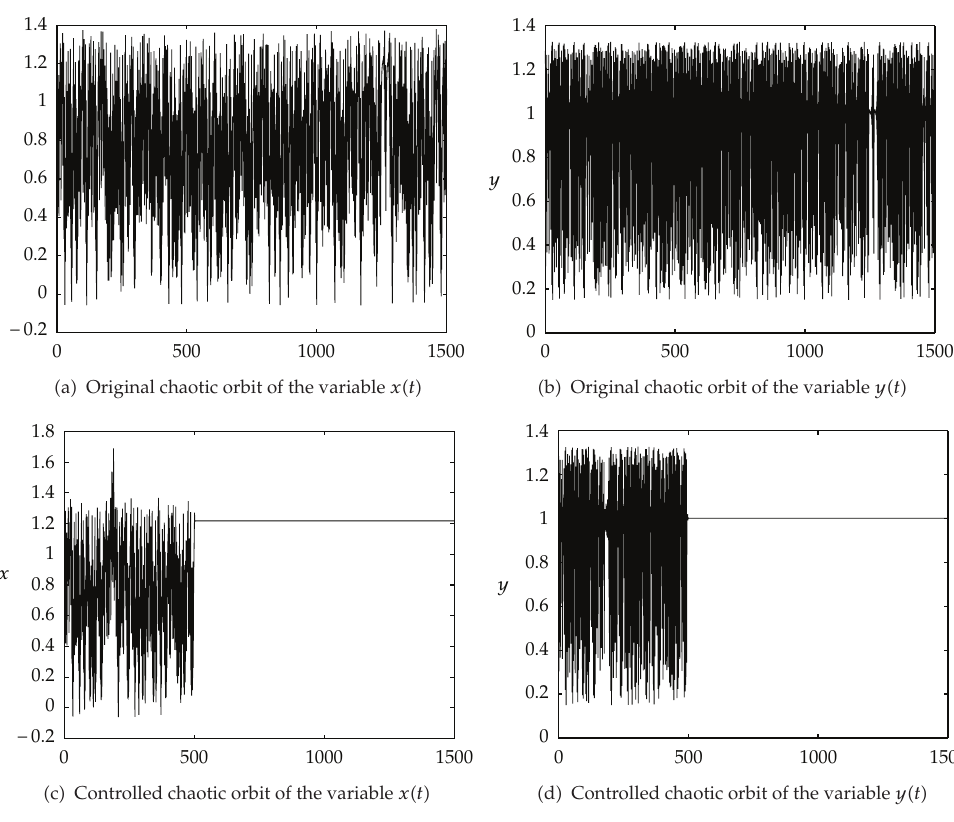
Figure 5: Comparison between the original and the controlled